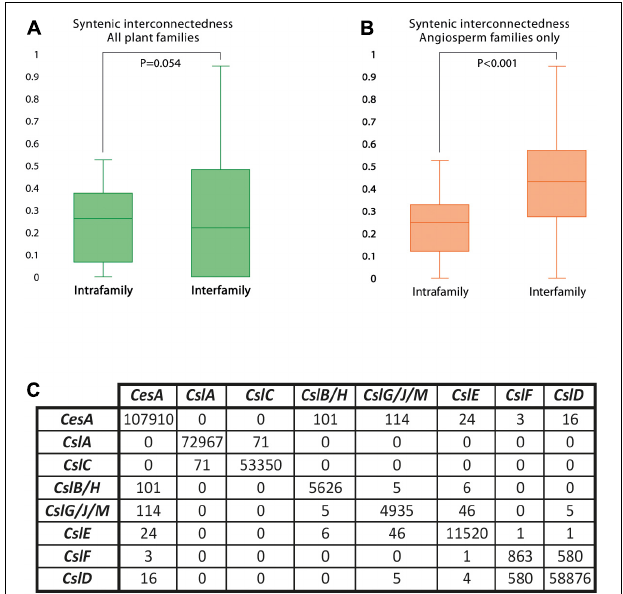
FIGURE 1 | The degree and structure of Cellulose synthase/Cellulose synthase-like ( CesA / Csl) gene synteny. Synteny is, overall, high and extensive across plant families, but arranged differently across gene families. (A) Distribution of the coefficients representing the average number of syntenic connections per gene in the CesA / Csl synteny network with other genes from the same (intrafamily) or from different (interfamily) plant species. Coefficients were calculated using data from all the plant families included in the analysis. (B) Distribution of the coefficients representing the average number of syntenic connections per gene in the CesA / Csl synteny network with other genes from the same (intrafamily) or from different (interfamily) plant species. Coefficients were calculated using data from only angiosperm families. (C) Total number of syntenic connections detected between gene families within the CesA